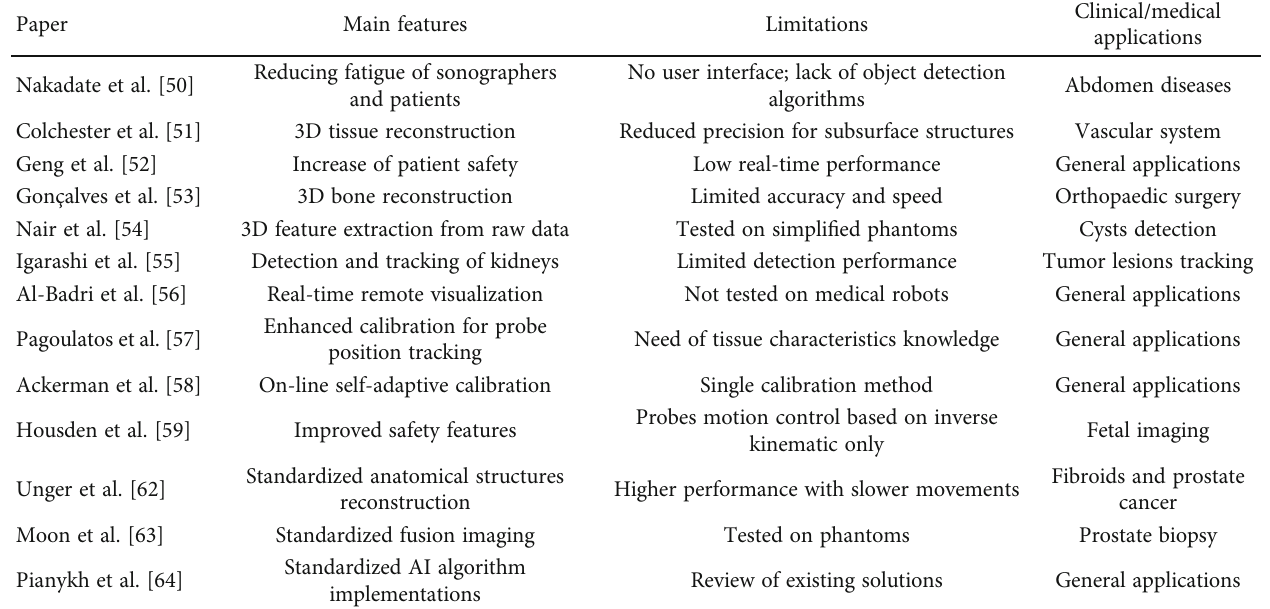
Table 4: Comparison of vision and image processing